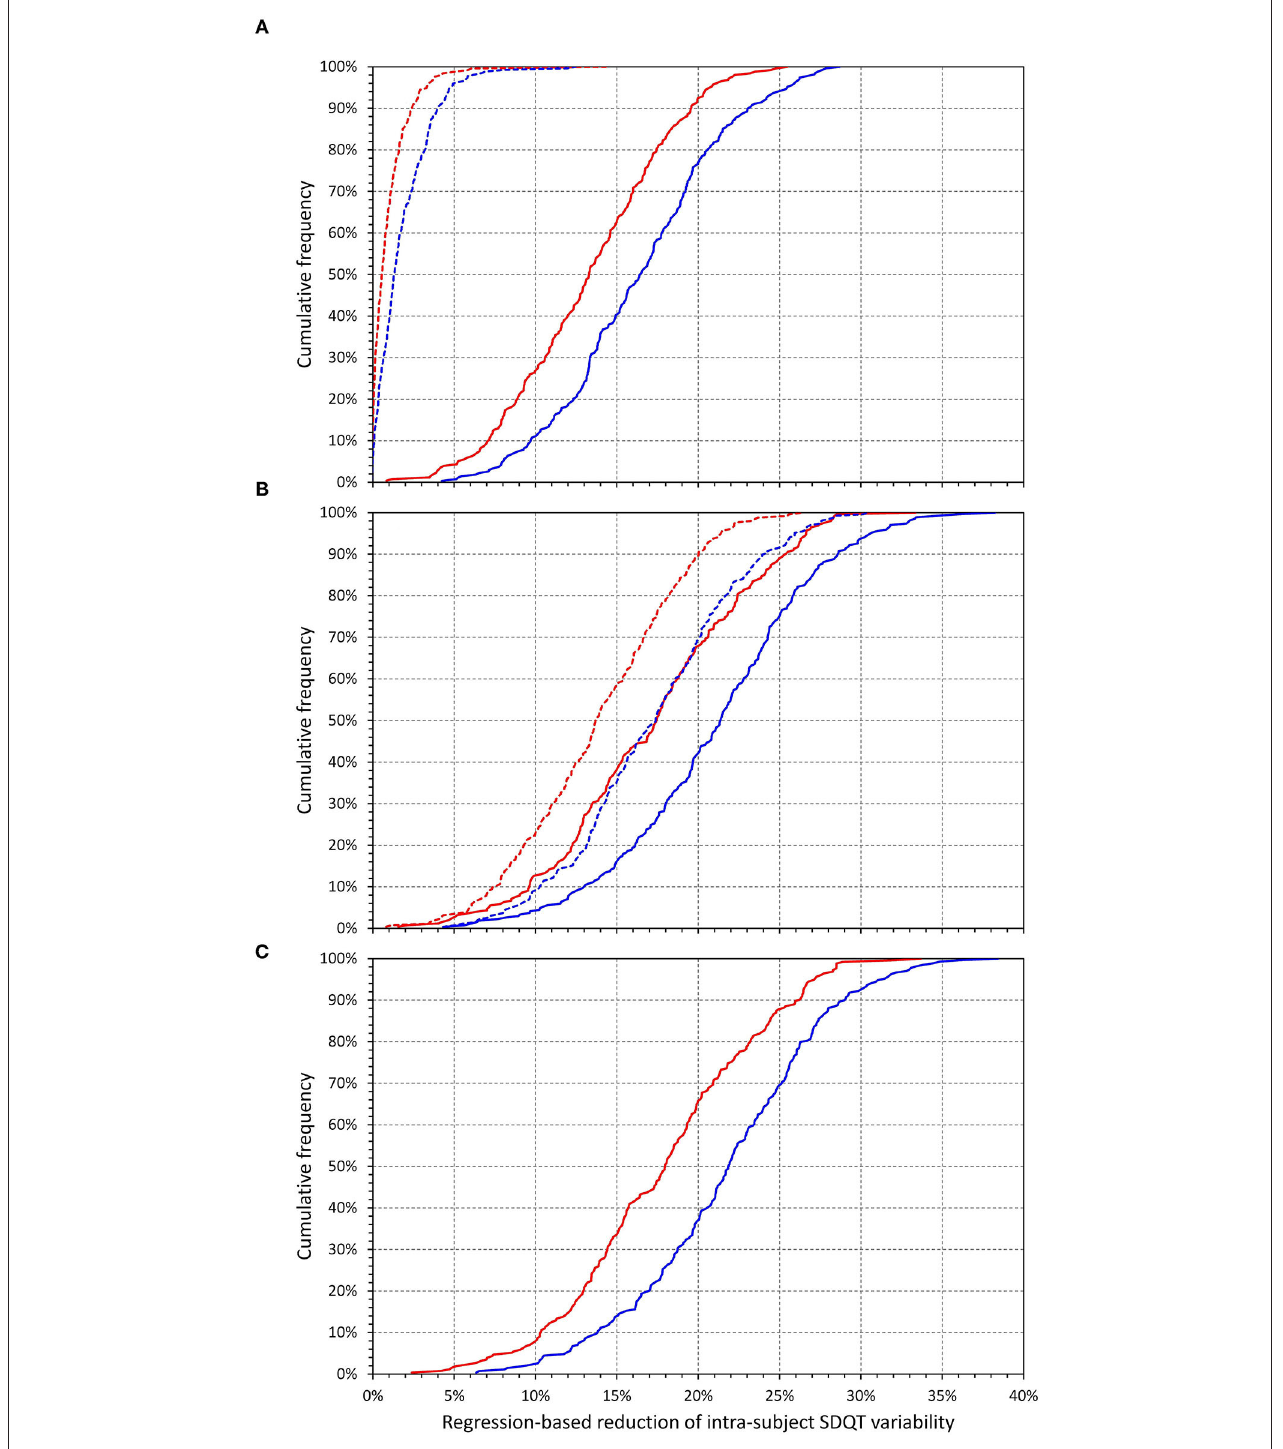
FIGURE 15 | Cumulative distributions of the relative decrease of intra-subject residuals of linear regressions SDQT calculated as proportions of intra-subject standard deviations of SDQT (see the section on Statistics and data presentation for details). The top (A) shows the reductions by 10-s median beat noise correction (solid lines) and by SDRR correction (dashed lines). The middle (B) shows reductions by a correction for a combination of 10-s median beat noise and SDRR (dashed lines) and for a combination of 10-s median beat noise, SDRR, and 10-s heart rate (solid lines). The bottom (C) shows reductions by a correction for a combination of 10-s median beat noise, SDRR, 10-s heart rate, and 10-s median QT interval duration. In each panel, the red and blue lines show the distributions among females and males, respectively.